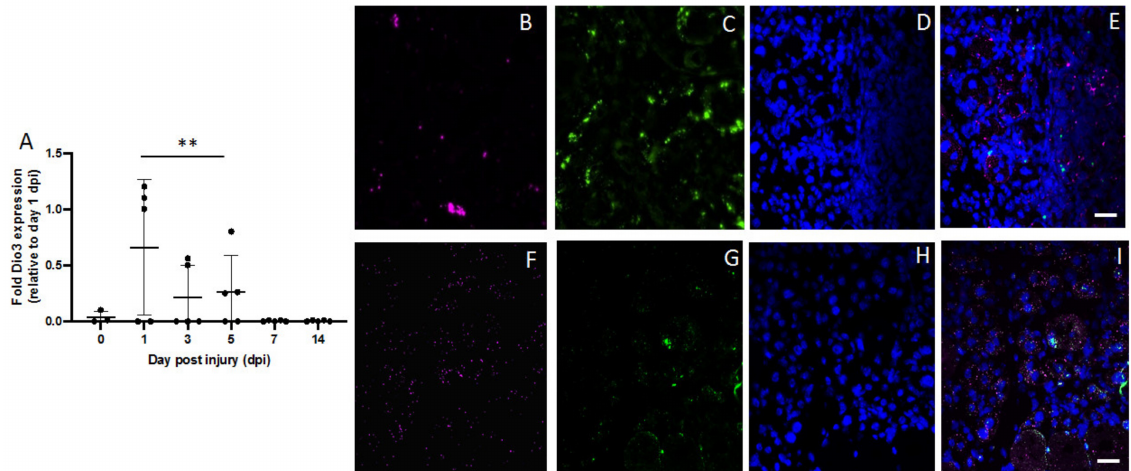
Figure 3. Dio3 and its expression in Pax7 + and MyoD + stem cells. ( A ) Dio3 expression between days 0 and 14 after injury in Pax7 + stem cells as measured by RT-PCR. ( B , C ) In situ hybridization showing expression of Dio3 (pink) and isolated Pax7 + cells (green) and DAPI ( D ) on day 5 post injury. ( E ) Dio3 expression in only a few Pax7 + cells. ( F , G ) In situ hybridization showing Dio3 (pink) expression and MyoD + cells (green), whereas DAPI is blue ( H ). ( I ) Merged image showing Dio3 expression on day 5 in MyoD + cells. ** p = 0.003. Data are expressed as the mean ± SEM of at least three independent experiments. Images are representative of injury on day 5 in one of five different mice analyzed ( n = 5). Scale bar = 50 µ